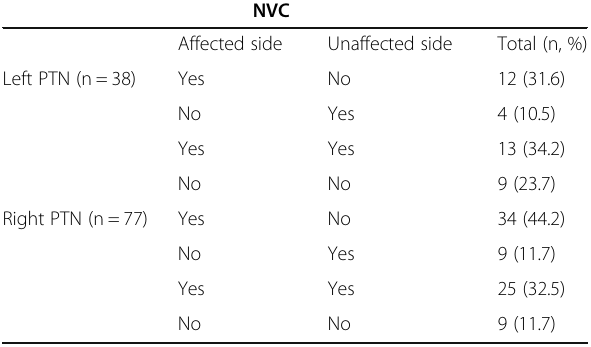
Table 3 Neurovascular contact (NVC) in PTN